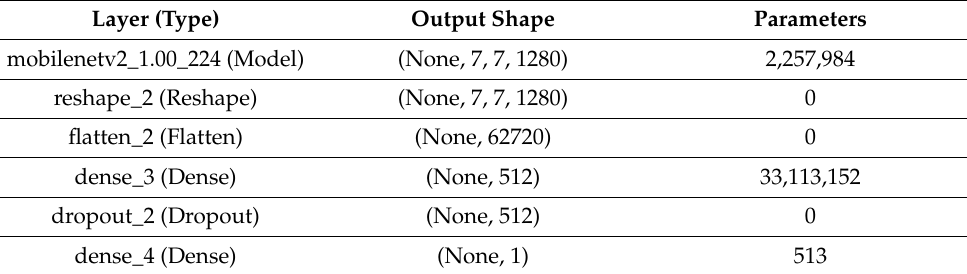
Table 5. The pre-trained MobileNetV2 model architecture.